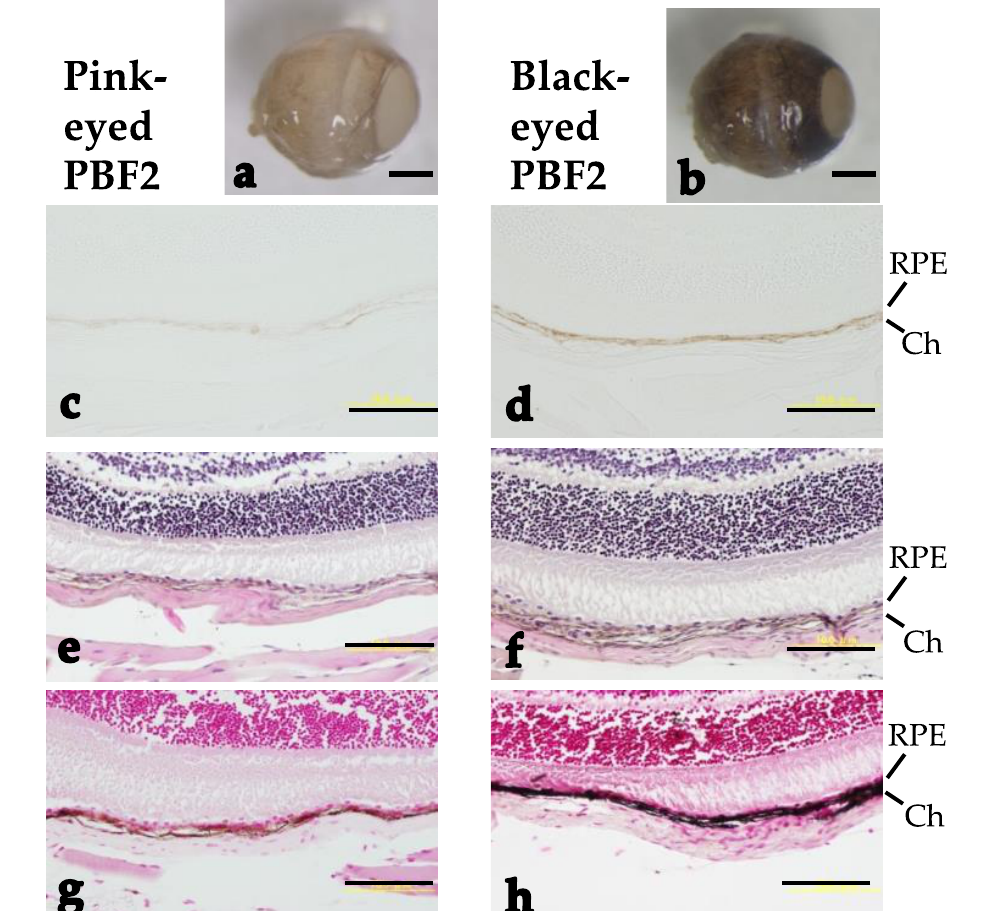
Figure 3. Stereomicroscopic and light-microscopic analyses of eyes from pink-eyed and black-eyed PBF2 male mice at 4 months of age: ( a , b ) Stereomicrographs; ( c , d ) unstained micrographs; ( e , f ) hematoxylin-eosin-stained micrographs; ( g , h ) Fontana-Masson-stained micrographs. RPE and Ch indicate retinal pigment epithelium and choroid, respectively. Scale bars show ( a , b ) 1 mm and ( c – h ) 100 µ m.